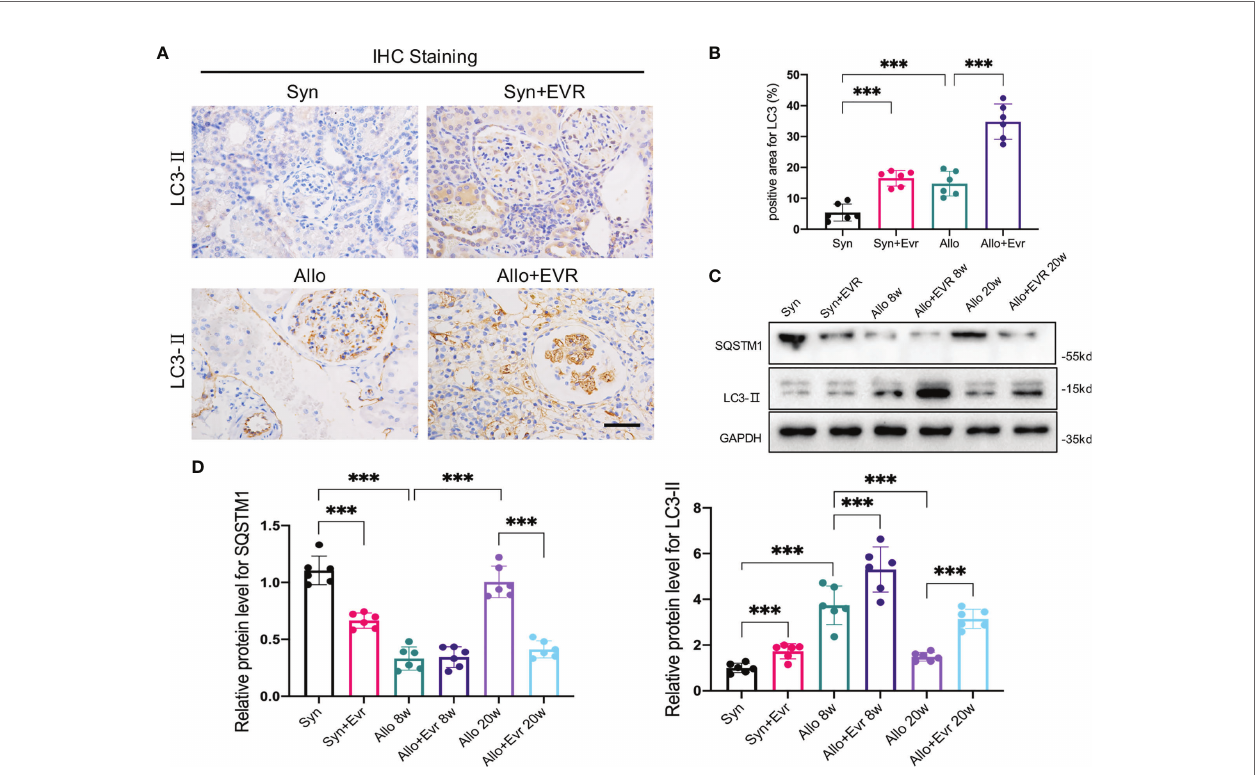
FIGURE 3 | EVR activated autophagy in CAD rat model. (A) Representative IHC images of LC3-II in kidney sections from different treatment group rats (scale bar: 15 m m). (B) Semi-quantitative analyses results of IHC positive area in kidney sections from different treatment group rats. Values represented the mean ± SD ( n = 6, *** p < 0.001). (C) Representative Western blotting results of autophagy markers (SQSTM1 and LC3-II) in kidney sections from different treatment group rats at 8 and 20 weeks. (D) Semi-quantitative analyses results of relative protein abundances of SQSTM1 and LC3-II in kidney sections from different treatment group rats at 8 and 20 weeks. Values represented the mean ± SD ( n = 6, *** p < 0.001). EVR,